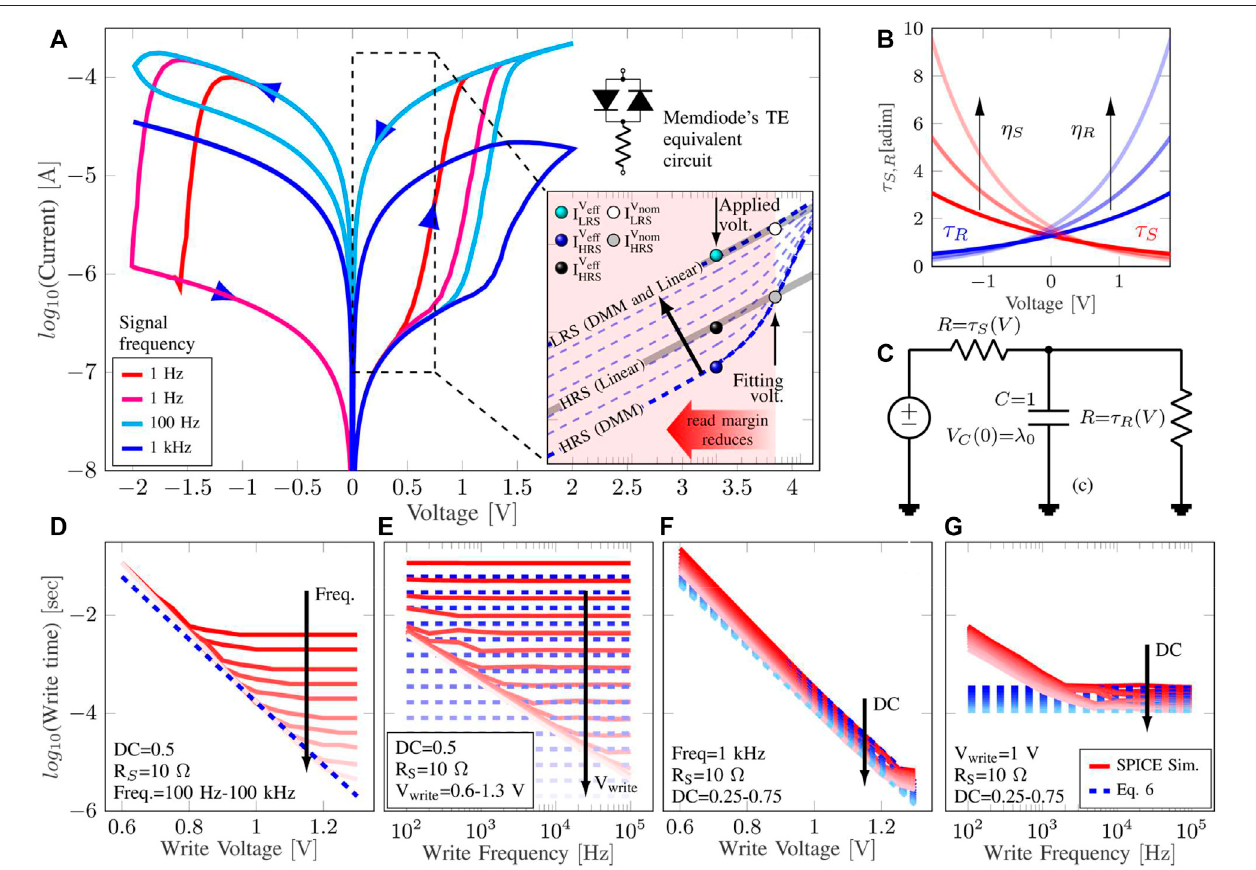
FIGURE 2 | (A) The inset in the left shows the equivalent circuit model for the current Eq. 1 including the series resistance. The diodes are driven by the memory equation with one diode activated at a time. The fi gure also shows typical simulated I-V characteristics for a memdiode. The current evolution is indicated by the blue arrows. Theinsetintherightsideshowstheexponential (HRS)tolineal(LRS)transitionbyvarying λ .Thered shaded regionindicatesthepossiblevoltagesapplied tothe device. I HRS and I LRS currents are pinpointed at the voltage used to fi t the linear model with the grey and white circle markers, respectively. Overestimation of I HRS may occur when consideringalinear model for the HRSregime and low applied voltages asindicatedby the cyan, blue and black ballmarkers. (B) Schematic model for theSET(red)andRESET(blue)characteristicswitchingtimesgivenby Eq.3 . (C) Equivalentcircuitmodelforthebalancedifferentialequation Eq.2 . λ isthememorystate (voltage) and λ 0 its initial value. Time required to reach a target current of 3 µA at 0.3 V, when using pulses of constant amplitude, studied as a function of (D) pulses amplitude (constant DC and varying frequency), (E) pulses frequency (constant DC and varying amplitude), (F) pulses amplitude (varying DC with constant frequency) and (G) pulses frequency (constant amplitude and varying